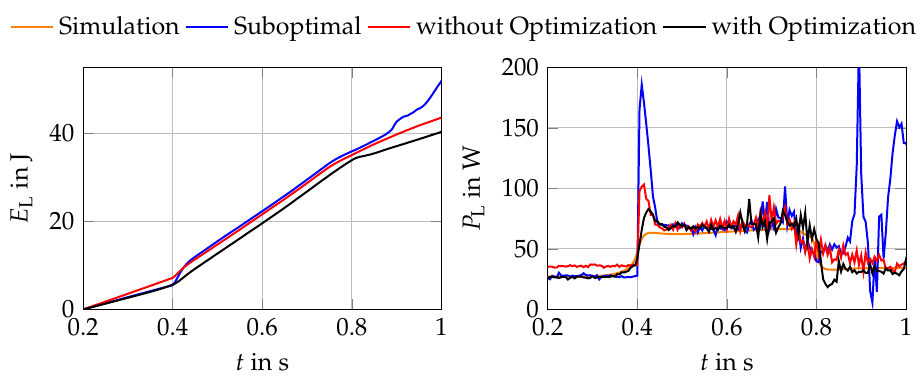
Figure 16. Comparison of measured energy and power